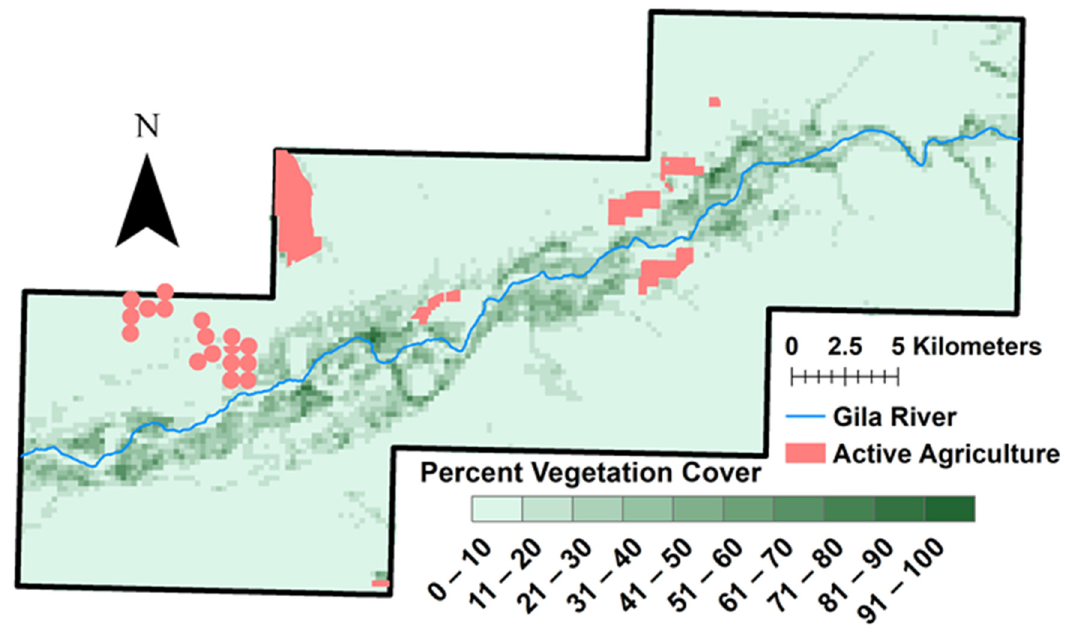
Figure A2. Percent Vegetation Cover 2007. 250 m tessellation of vegetation cover in 2007. Areas with less cover are shown in light green and areas with greater cover are shown in dark green. Areas of active agriculture are shown in pink. Land 2020 , 9 , x FOR PEER REVIEW